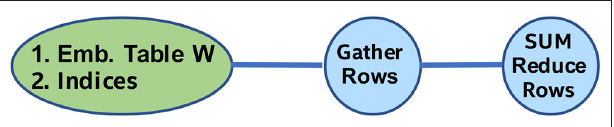
FIGURE 17 | Sparse Embedding Lookups via TPPs. Algorithm 5 | Sparse Gather-Reduce operation.